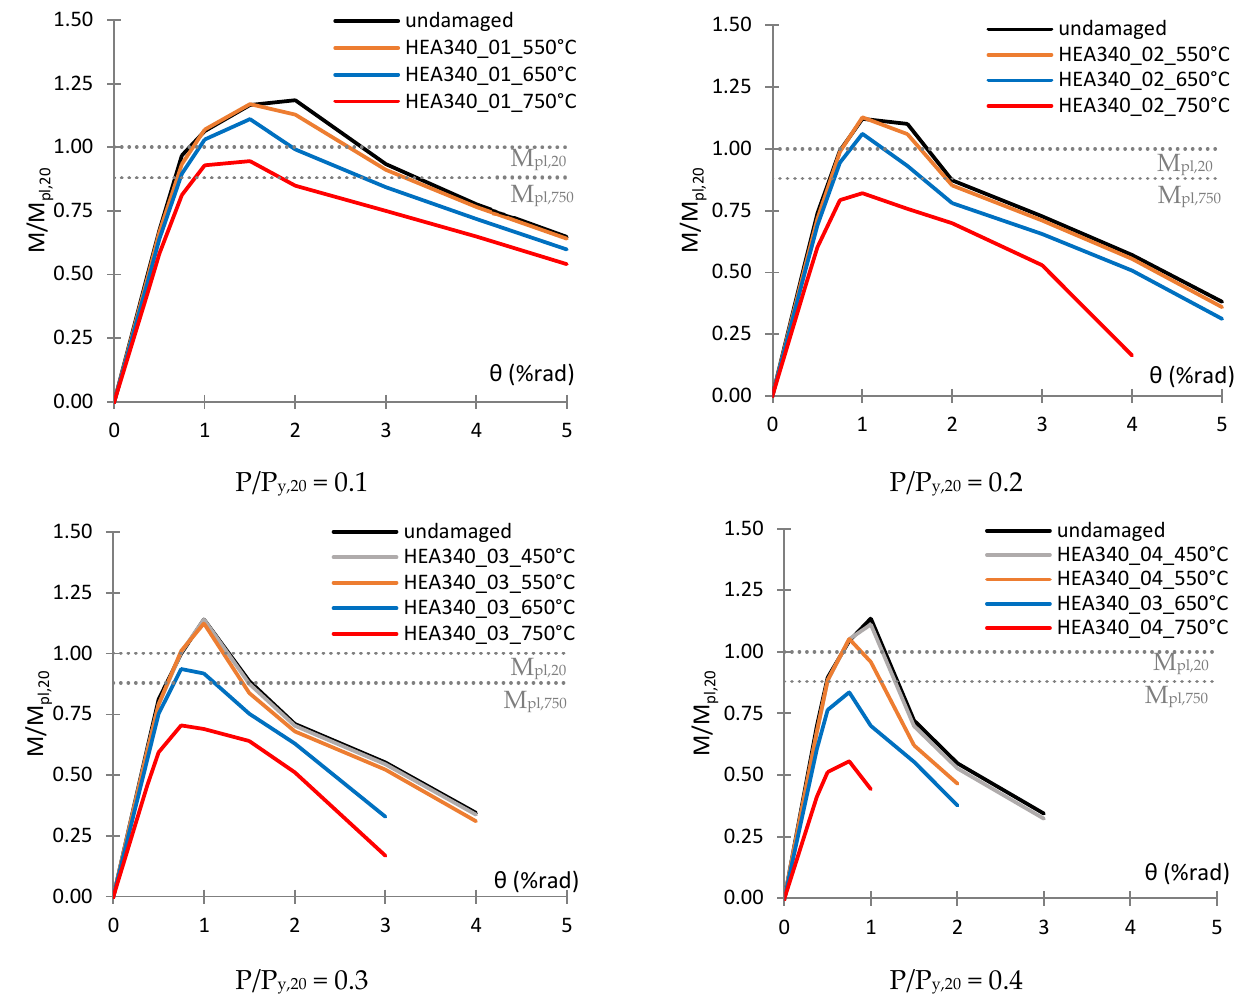
Figure 15. First cycle envelope curves for the moment M x at the base of the HEA340 columns. Table 4. Summary of the results for the HEA340 columns.